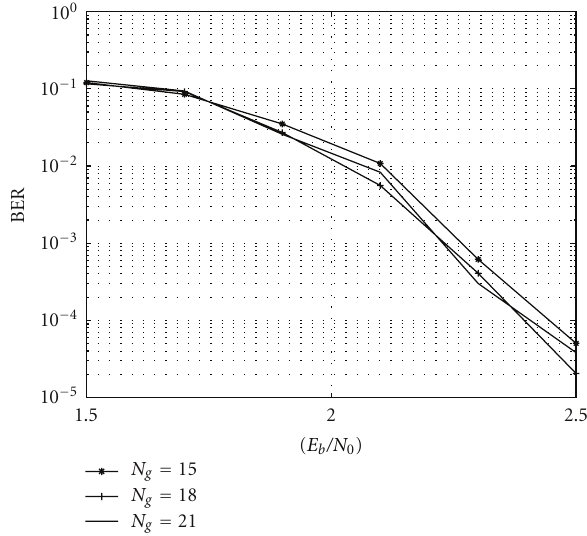
Figure 5: E ff ect of the generation number for (16, 11, 4) 3 at 12th iteration on